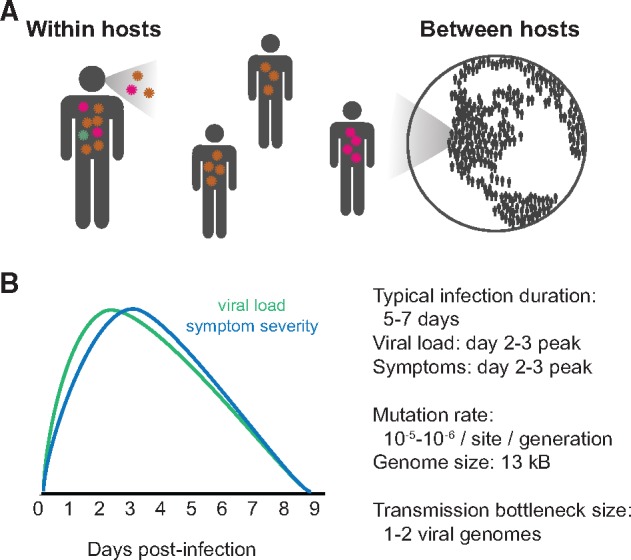
Influenza virus evolves at within- and between-host (or global) evolutionary scales. (A) Viral mutations that arise within hosts can transmit from person to person and eventually contribute to global viral evolution. (B) Key parameters affecting influenza’s evolution within hosts. Estimates of infection duration, viral load, and symptom severity are summarized from meta-analyses of volunteer challenge studies (Carrat et al. 2008) and mathematical models of viral infection (Baccam et al. 2006; Beauchemin and Handel 2011). Viral mutation rates are summarized from studies by Suarez-Lopez and Ortin (1994), Nobusawa and Sato (2006), Sanjuán et al. (2010), and Bloom (2014). Transmission bottleneck size has recently been estimated from deep sequencing of viral samples from household transmission pairs (McCrone et al. 2018).